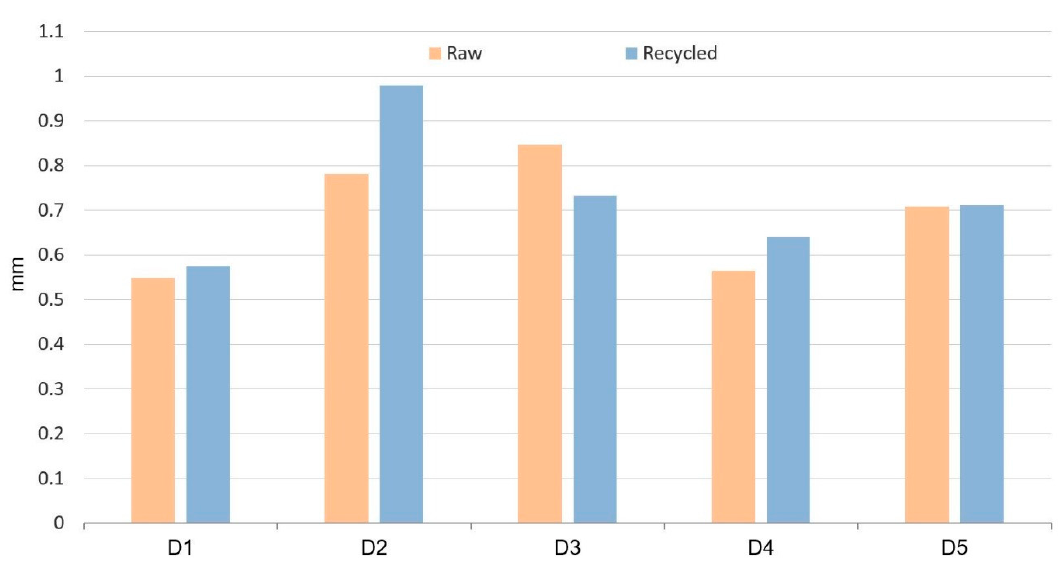
Figure 7. Dimension differences between heated samples at 50 °C and samples heated at 80 °C, after stabilization at room temperature.